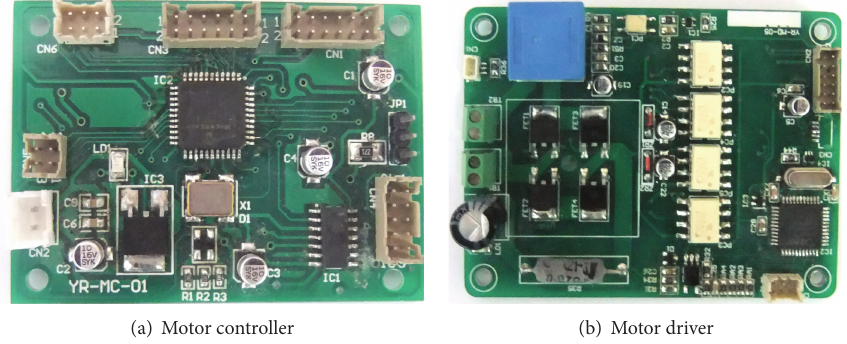
Figure 7: The controller and driver of motor.